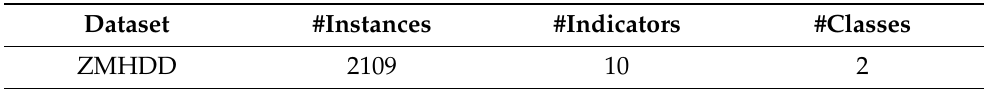
Table 2. Parameters of the ZMHDD diabetes